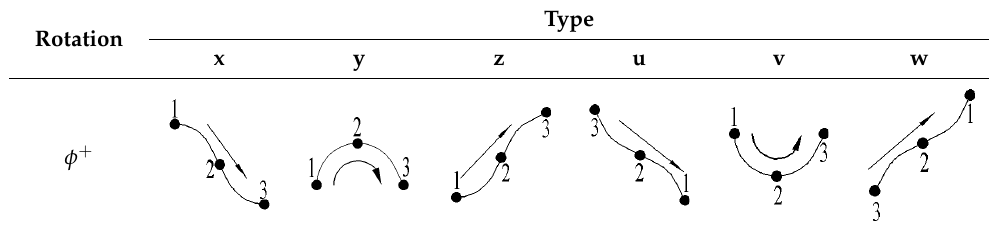
Figure 5. Units of basic track type, derived from Figure 4. Table 1. Position and direction of the carriers in each basic track type. Rotation